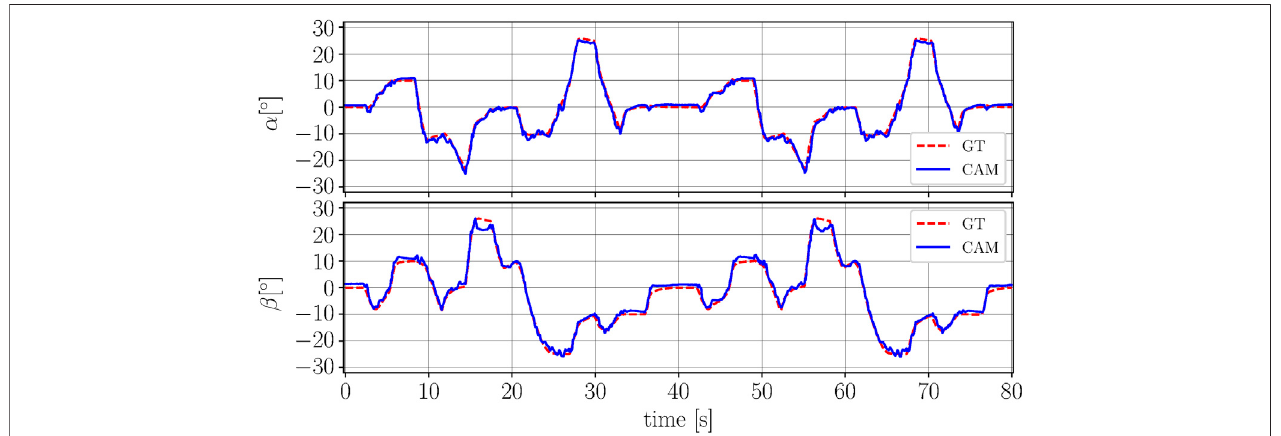
FIGURE 8 | The fi gure shows the rotational degrees of freedom α (top plot) and β (bottom plot) over time. The camera-based prediction (CAM) is shown in blue (solidline)andthegroundtruth(GT)fromthemotioncaptureisdepictedinred(dashedline).No fi lteringisappliedtotheoutputfromthenetwork.Slightdeviationscanbe seen for large values of β . The deviations between the two repetitions of the trajectory are comparable.